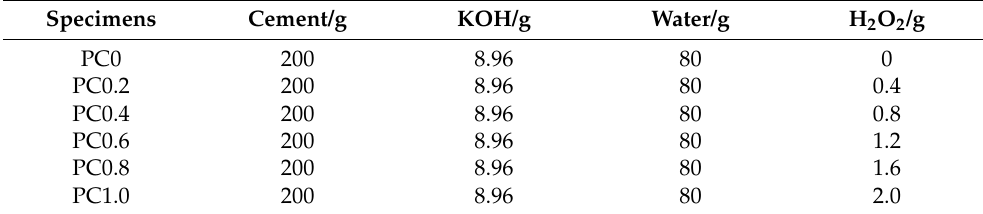
Table 1. Mix design of cement